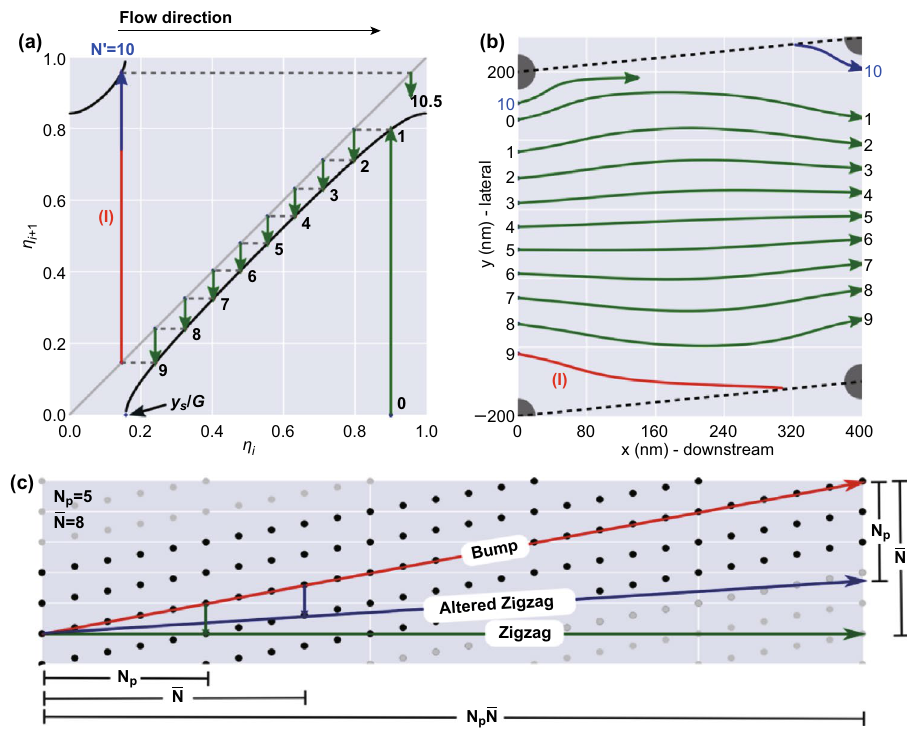
Fig. 3 Unified DLD separation model. a The recurrence map of the particle trajectories generated from ten DLD unit cells along the array with D D D N 0 = 40 nm, L = D = 400 nm and p = 10 shows that the particle position at the end of the period is not the same as the initial position. The arrow represents the particle trajectory direction, the green line is the direct transition, the red line is the zigzag transition on the veering stream- lines ( I ), and blue line depicts the particle enters the adjacent DLD cell unit. b The superimposed particle trajectories from ten DLD cells, which show the beginning and the ending positions of particles in each DLD cell. c Three different displacement modes of bump, altered zigzag, and zigzag from the unified DLD model. Figure panels reproduced from Ref. [30] with permission from the National Academy of Science, copyright 2017. (Color figure